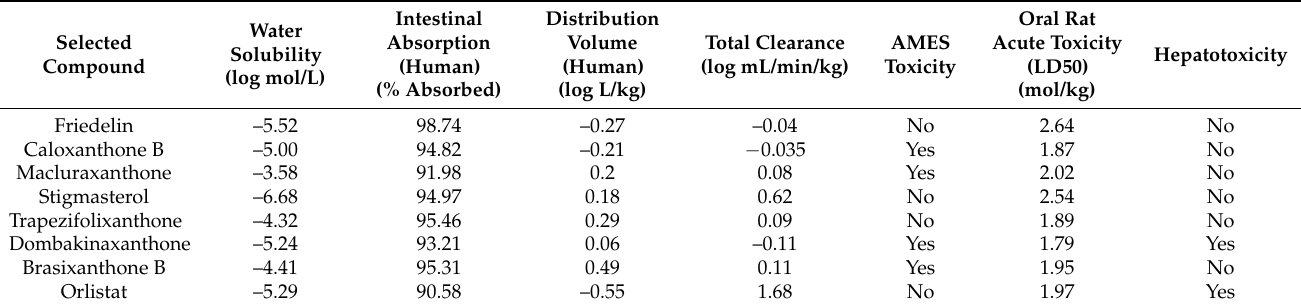
Table 6. Predictive pharmacokinetic and toxicity parameters of selected compounds in Calophyllum soulattri